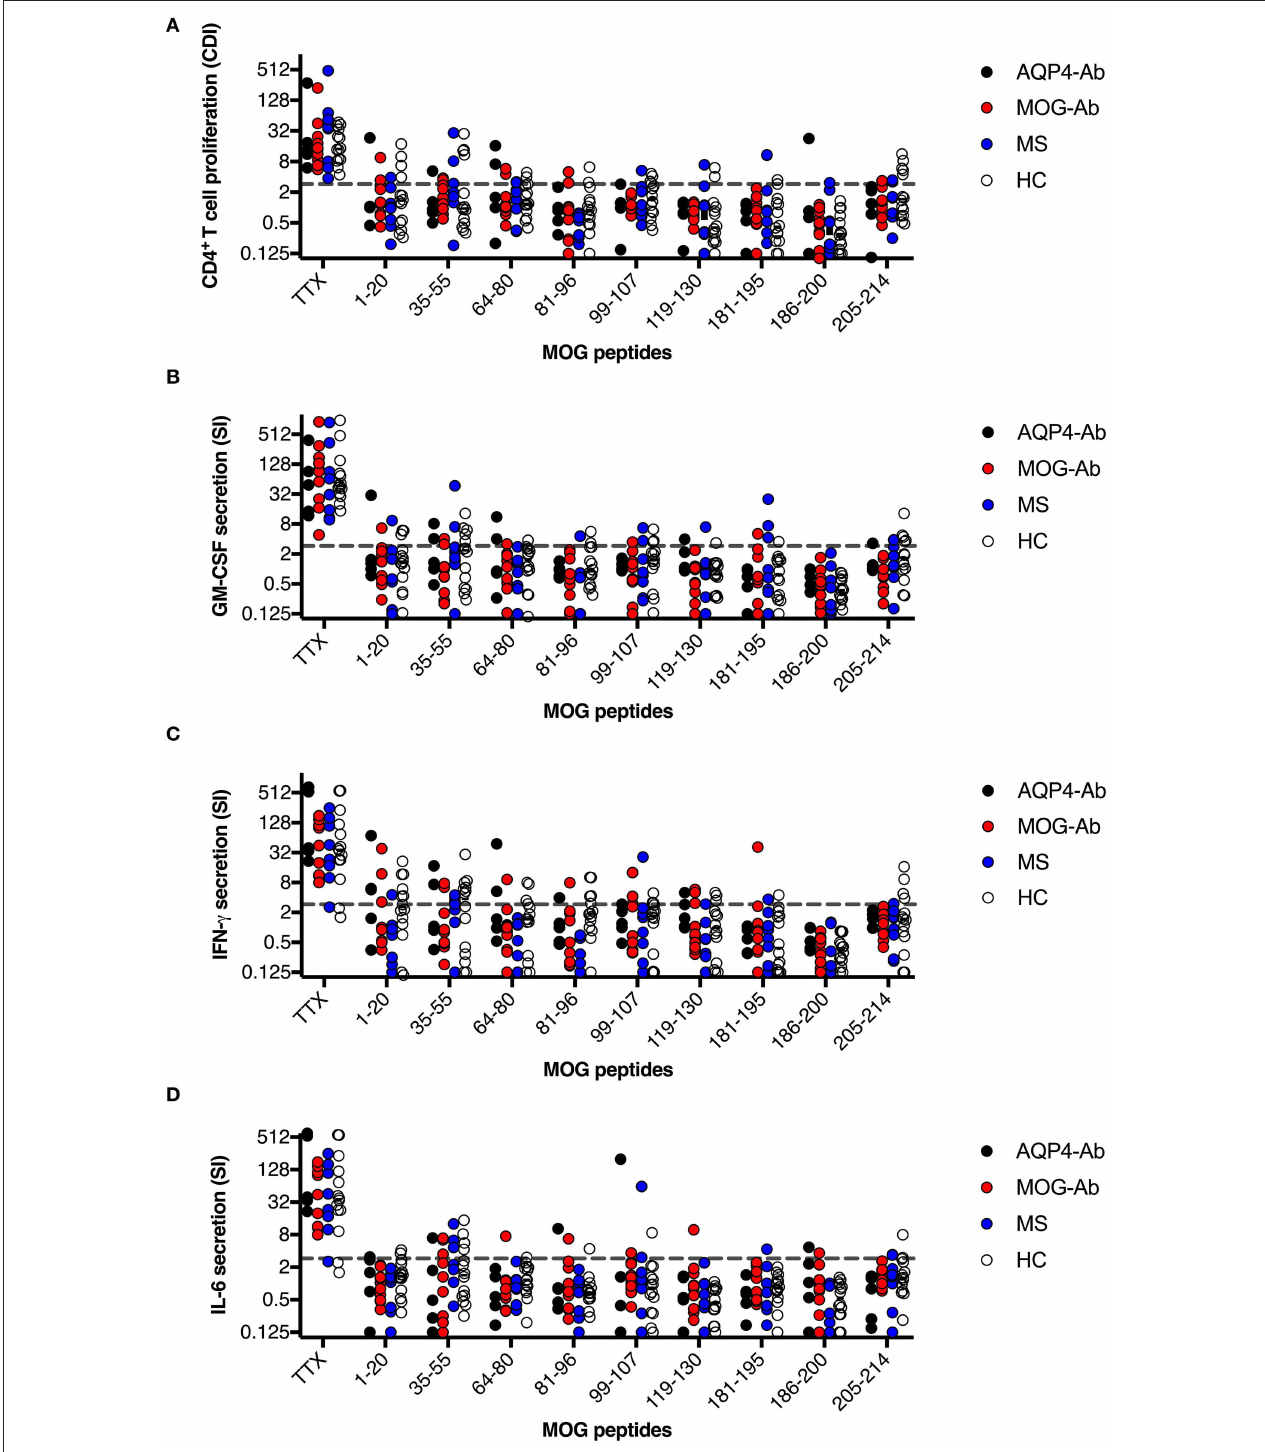
FIGURE 6 | CD4 + T-cell reactivity to MOG peptides in participants with AQP4-Ab ( n = 5), MOG-Ab ( n = 10), MS ( n = 8) and HC ( n = 14). (A) CD4 + T-cell proliferation after challenging with respective MOG peptides and the positive control TTX. The cut-off value of a CDI ≥ 3 is indicated by a gray dashed line. Secretion of GM-CSF (B) , IFN- γ (C) and IL-6 (D) after challenging with respective MOG peptides and the positive control TTX. The cut-off value of a SI ≥ 3 is indicated by a gray dashed line. AQP4-Ab, aquaporin-4 antibody positive; CDI, cell division index; GM-CSF, granulocyte-macrophage-colony-stimulating factor; HC, healthy controls; IFN, interferon; IL, interleukin; MOG-Ab, myelin oligodendrocyte glycoprotein antibody positive; MS, multiple sclerosis; SI, stimulation index; TTX, tetanus toxoid.